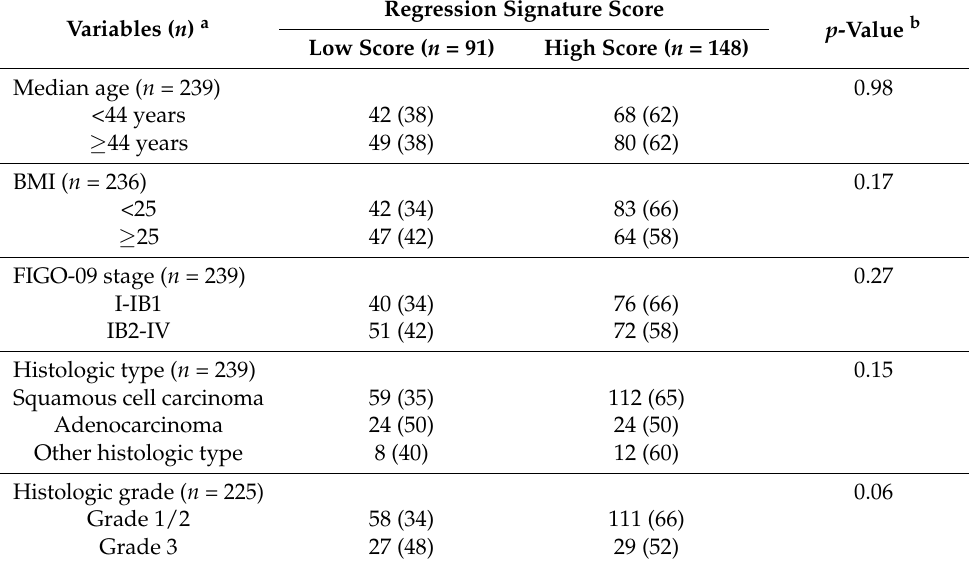
Table 2. Distribution of available clinicopathological characteristics for the cervical cancer patients according to regression signature score. The number of cases in each group is given followed by percentage for each row in